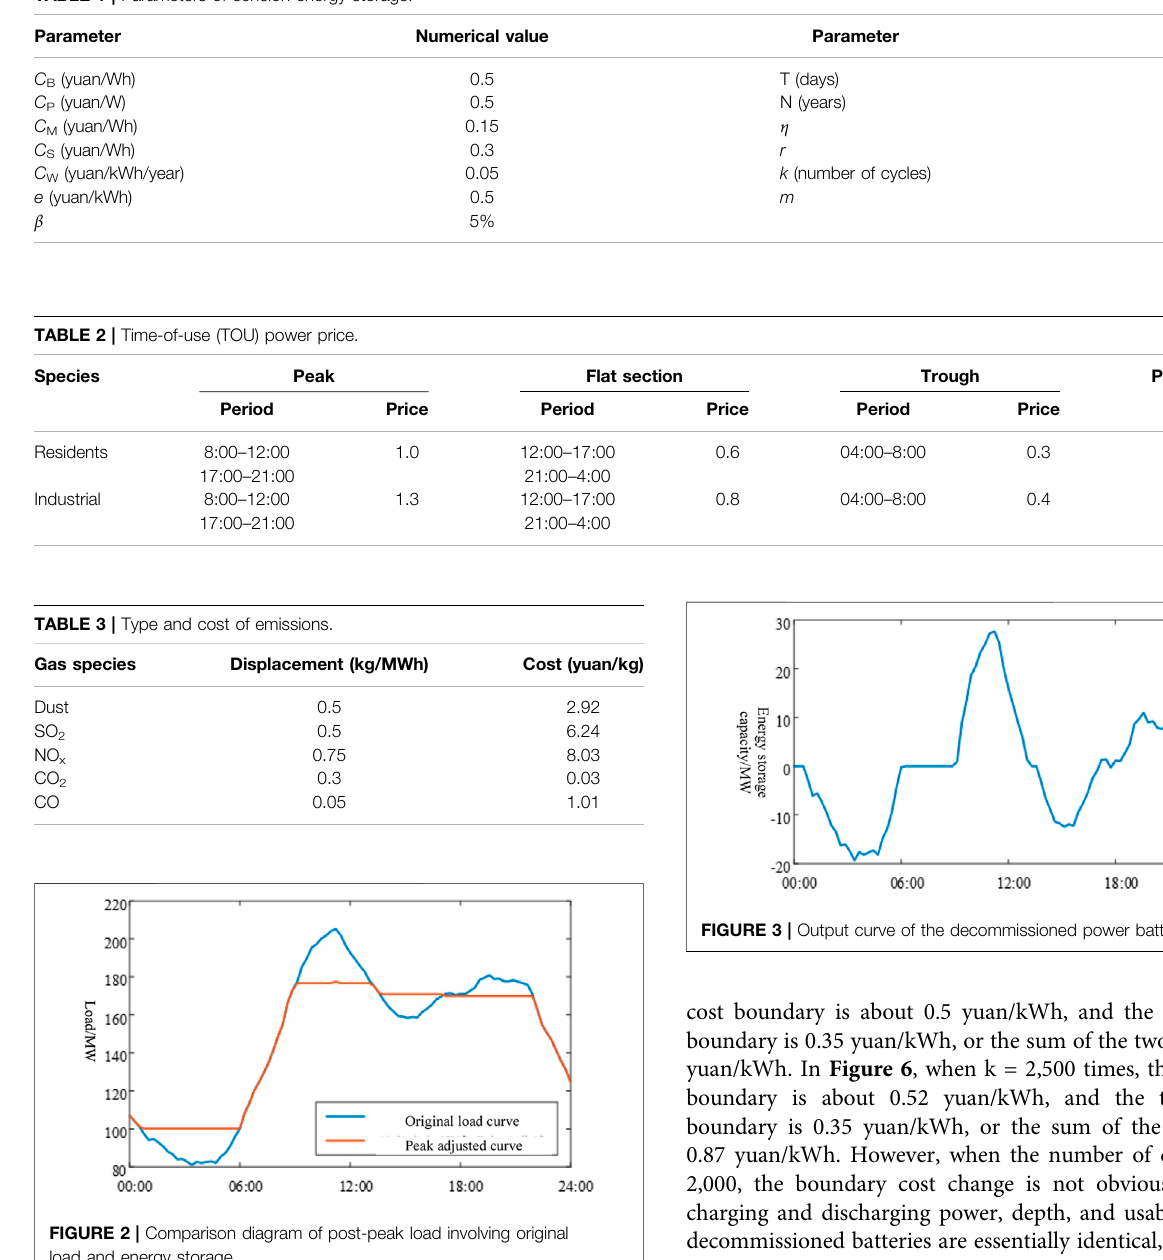
TABLE 1 | Parameters of echelon energy storage.